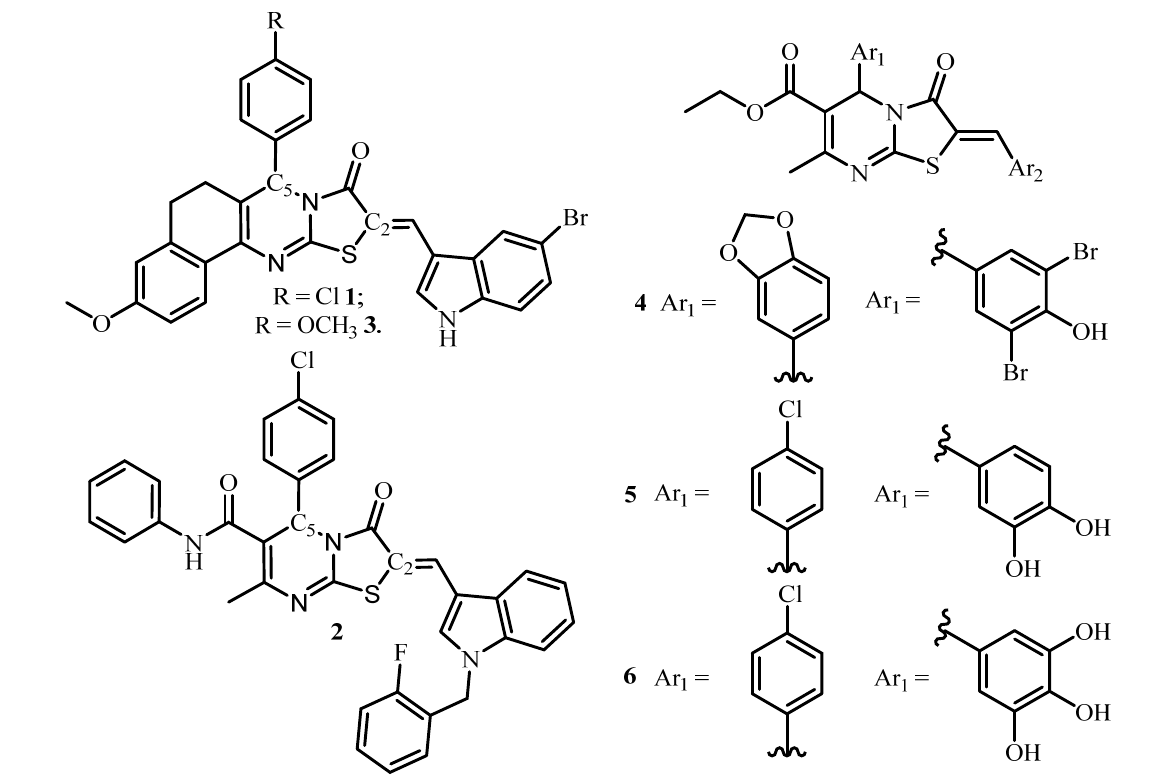
Figure 1. Thiazolo[3,2- a ]pyrimidine compounds used as promising enzyme inhibitors and antitumor drugs.